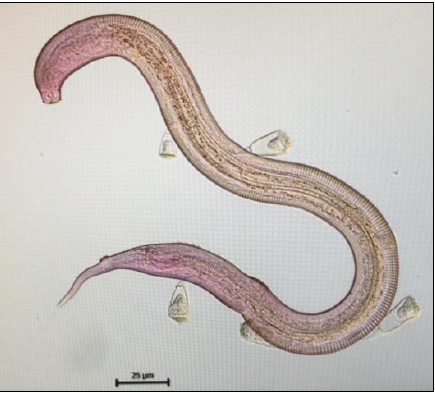
Figure 6. Picture of a nematode ( Desmodora sp. ) with epibionts. Credit @Claire Michelet.